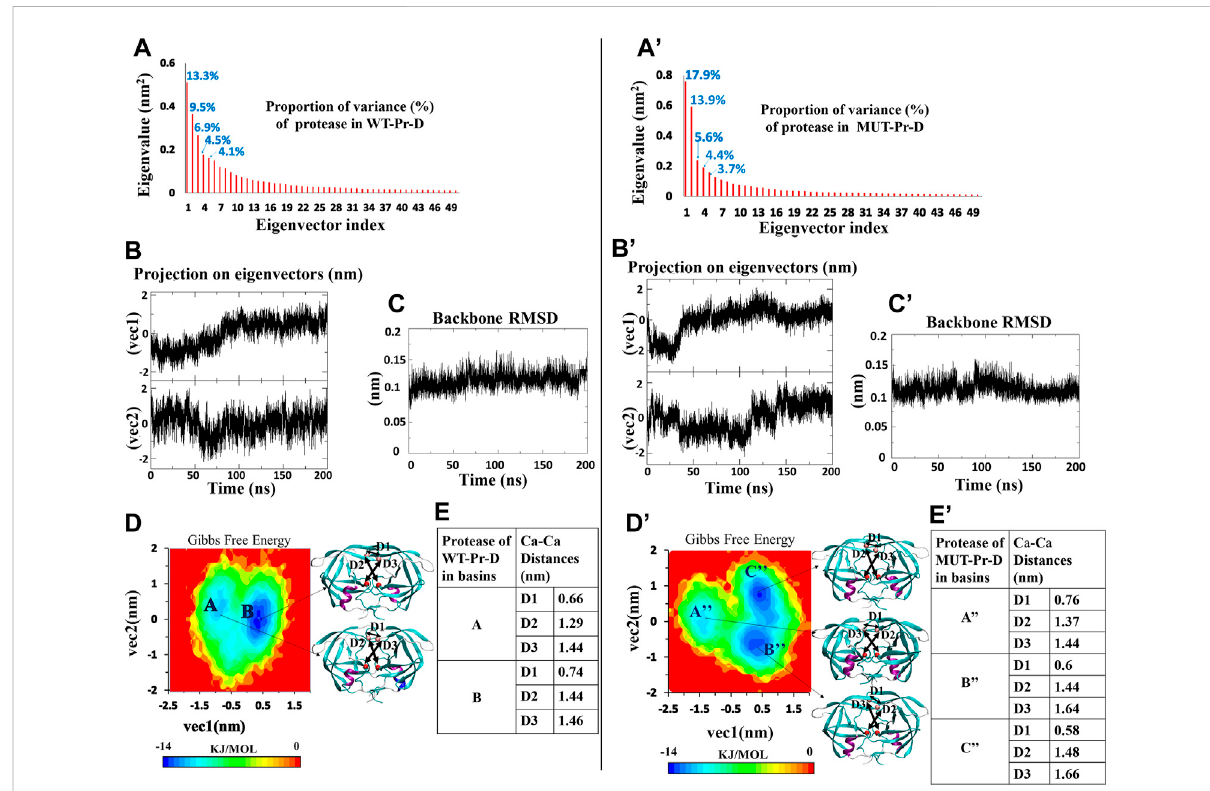
FIGURE 2 PCA for WT-Pr (left) and MUT-Pr (right) in complex with DRV, (A,A ’ ) Eigenvalue for each corresponding eigenvectors( fi rst 50 eigenvectors) and proportion of the variance with respect to corresponding eigenvectors; (B,B ’ ) The projection of trajectory on the two fi rst eigenvectors (PCs); (C,C ’ ) The backbone RMSD for the proteases; (D,D ’ ) The free energy landscape obtained from fi rst two eigenvectors and protease structures having the lowest free energy; (E,E ’ ) Distances between C α of the residues I50-I50 ’ : D1, D25-I50: D2 and D25 ′ -D50 ’ : D3 for the protease structures in the low-energy